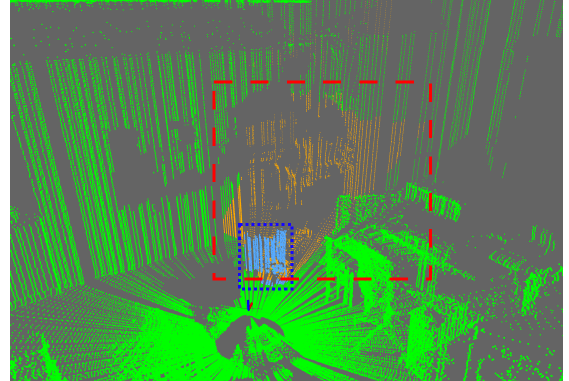
Figure 11: Cleaned scan of office room with a mirror. Valid points are green, points on the mirror plane are turquoise, and points behind the mirror plane are orange.